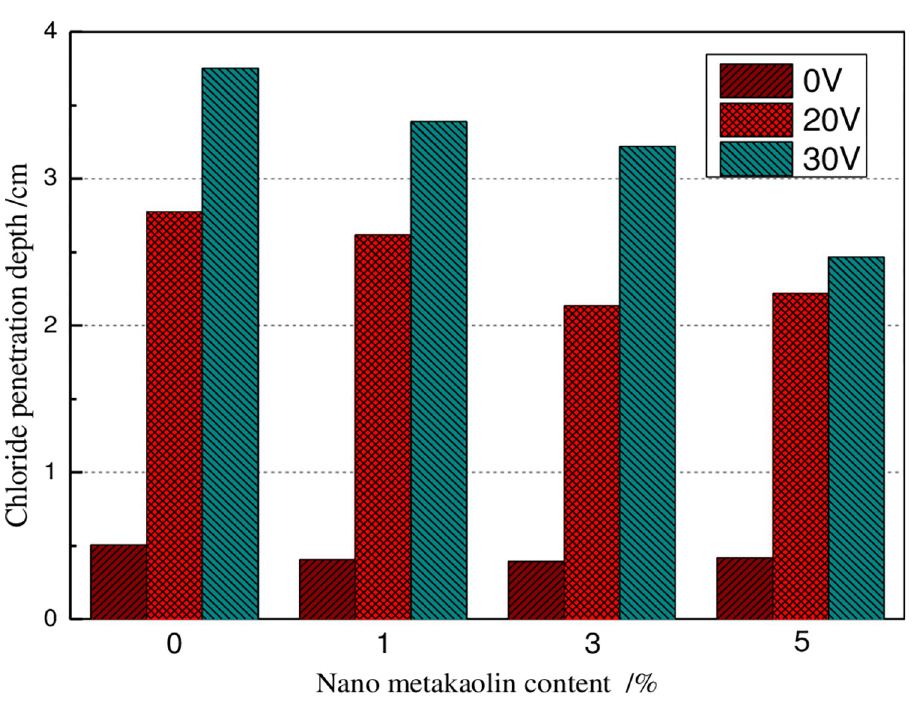
Fig 5. Chloride diffusion depth of GO added concrete under the electric